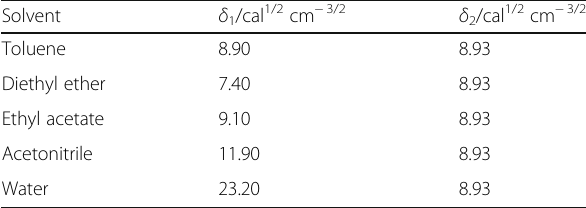
Table 2 Solubility coefficients of DSHPG and different